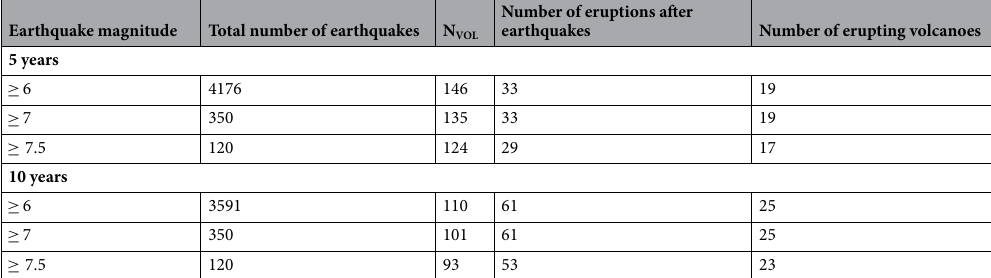
and significant volcanic activity 21 , which implies that such dormant volcanoes are also triggered by static dilata- tional strains caused by large earthquakes. The distributions of the lag times for the other strain ranges, even for compressional strains, are similar to those for ε ≥ 0.5 µ within approximately 5–10%. This suggests that the trig- gered and non-triggered volcanoes are not discriminated from the characteristics of previous eruptive activities. The static dilatational strain plays a role in triggering gas bubble growth to promote upward magma migration